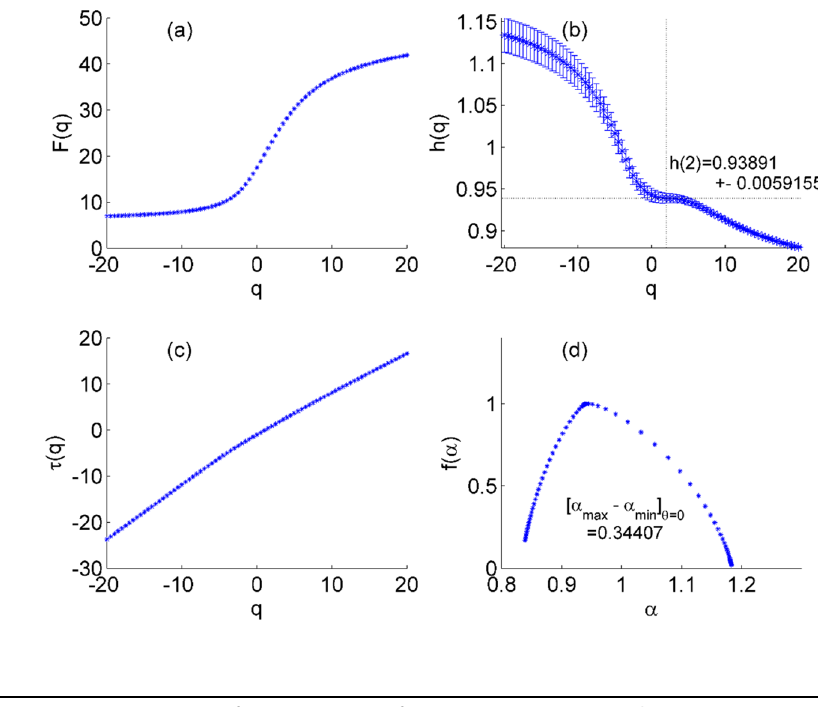
Fig. 6 a F ( q ) versus q , b h ( q ) versus q , c 𝜏 ( q ) versus q , d f ( 𝛼 ) versus 𝛼